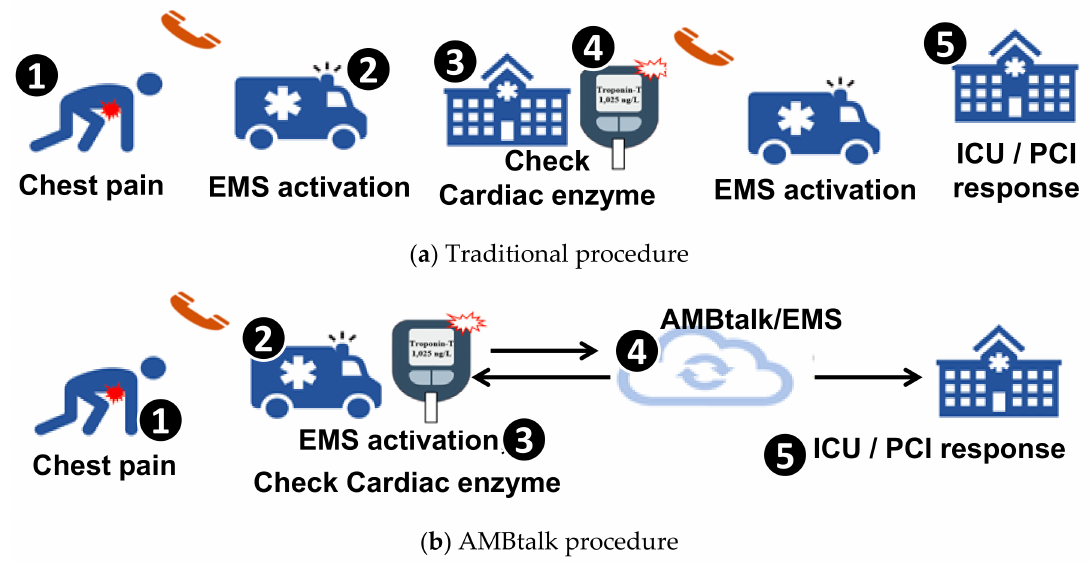
Figure 1. The Emergency Medical Service (EMS) procedures for ambulance; ICU: Intensive Care Unit; PCI: Percutaneous Coronary